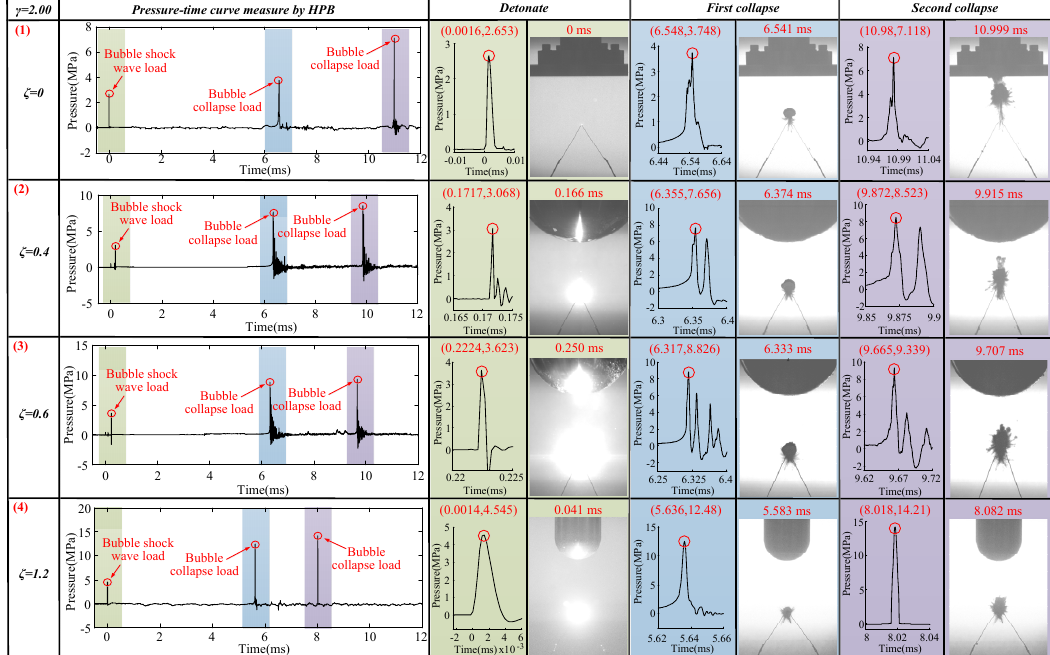
Figure 21. Pressure–time diagram for γ = 2.00 and different ζ values. The first row shows the pressure–time curves for the states of ζ = 0 and γ = 2.00. The second row shows the pressure–time curves for the states of ζ = 0.4 and γ = 2.00. The third row shows the pressure–time curves for the states of ζ = 0.6 and γ = 2.00. The fourth row shows the pressure–time curves for the states of ζ = 1.2 and γ = 2.00.